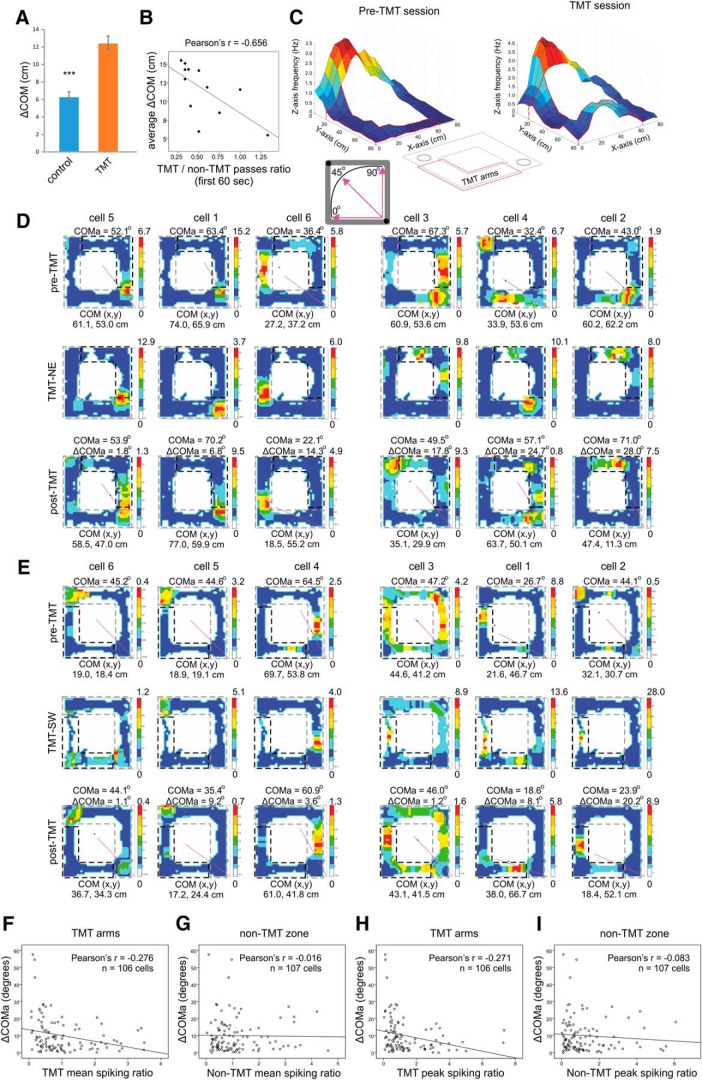
Individual place field reconfiguration after exposure to TMT. A, COM shift (ΔCOM) of place cells recorded from a control group of rats exposed to familiar odor (10% ethanol) and group of rats exposed to innately aversive odor (10% TMT); ***p < 0.001. Error bars, mean ± SEM. B, Correlation between the average ΔCOM for each rat and the ratio of the TMT- over the non-TMT arms passes for the first 60 s of the post-TMT session. C, left, Color-coded 3D-spatial map of a sample place cell with place field located outside the TMT arms (the TMT arms are marked with a red line), recorded during pre-TMT session. The x- and y-axes represent the coordinates of the rectangular track, while the z-axis and color scale represent the firing rate of the recorded neuron. Right, As left, but recorded during the TMT session. The inset below shows the position of the TMT arms with a red line (circles indicate the pellet delivery corners). The spiking TMT ratio represents the mean (peak) firing rate of the pre-TMT session over the TMT session. The inset below shows the radial representation of COMa. The straight purple line indicates the COM position with respect to the main axis of the track between the food zones (black dots). A value of 45° indicates a COM that is evenly distributed across the main axis of the track, 0° indicates COM fully distributed within the SW section and 90°, in the NE section of the track. D, Six sample place cells recorded from rat of the NE group during pre-TMT session (upper panels), TMT session (middle panels), and post-TMT session (lower panels). The straight purple line denotes the COMa for each cell between SW at 0° and NE at 90°. Note that some of the place cells exhibited a higher firing rate in the TMT arms during the TMT sessions (panels positioned on the right half) compared to place cells with little or no spiking (panels positioned on the left half). E, Six sample place cells recorded from rat of the SW group during pre-TMT session (upper panels), TMT session (middle panels), and post-TMT session (lower panels). F, Correlation between ΔCOMa and TMT spiking ratio based on the mean spiking rate of the place cells in the TMT arms. G, Correlation between ΔCOMa and non-TMT spiking ratio on the mean spiking rate of the place cells in the non-TMT zone. H, As for F, but with peak TMT spiking ratio instead of mean TMT spiking ratio. I, As for G, but with peak TMT spiking ratio instead of mean TMT spiking ratio.